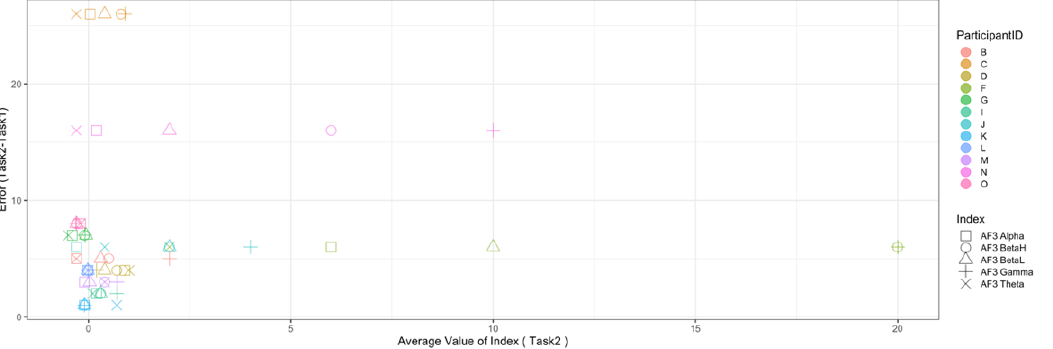
Figure 14. Scatterplot between the number of errors of Task2 vs. the EEG indexes during Task2. (Note that the scatterplots include only EEG channel with significant correlation (AF3), as summarized in Table 17).